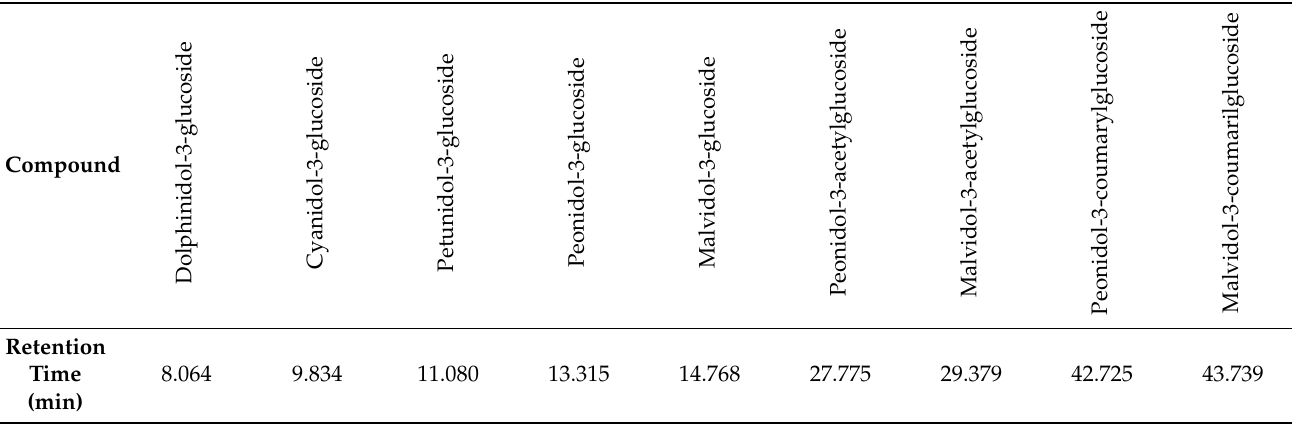
Table 5. Anthocyanins used as standards in HPLC analysis and their retention